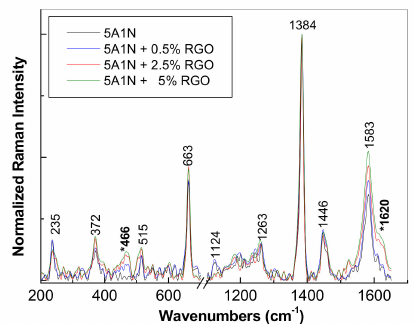
Figure 2. Raman spectra of 5A1N (black curve) and the 5A1N / RGO mixtures with RGO sheets concentrations equal to 0.5 wt. % (blue curve), 2.5 wt. % (red curve) and 5 wt. % (green curve).